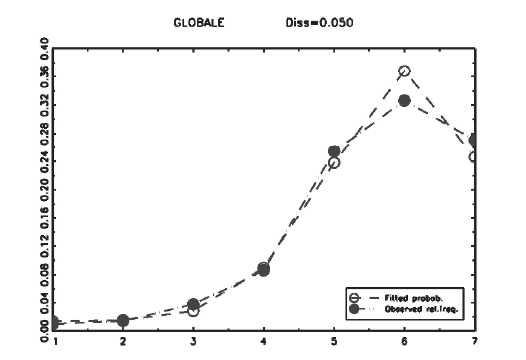
Figure 2 – Observed and estimated distribution for global preference.